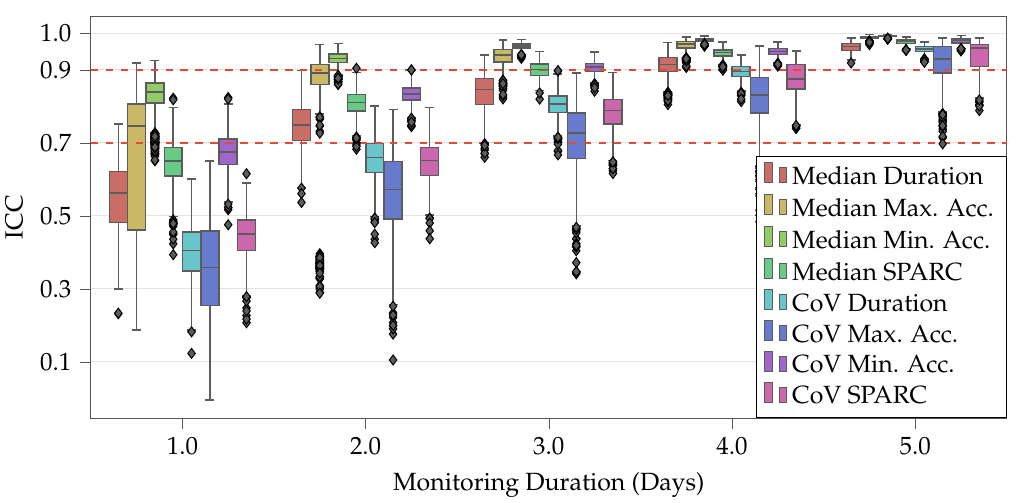
Figure 3. Comparison of STS features during random subsets of one to five days with STS features derived using six consecutive days across all healthy subject study participants. 0.7 and 0.9 cutoffs are marked as dashed lines. ICC was two-way random effects, absolute agreement, and single rater/measurement. From left to right, features are median duration, median of maximum acceleration, median of minimum acceleration, median SPARC, CoV of duration, CoV of maximum acceleration, CoV of minimum acceleration, and CoV of